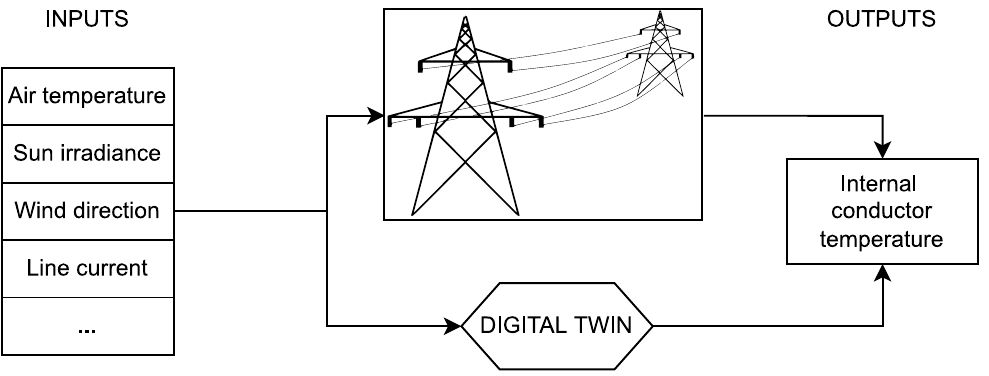
Figure 1. High-level overview of the proposed Digital Twin